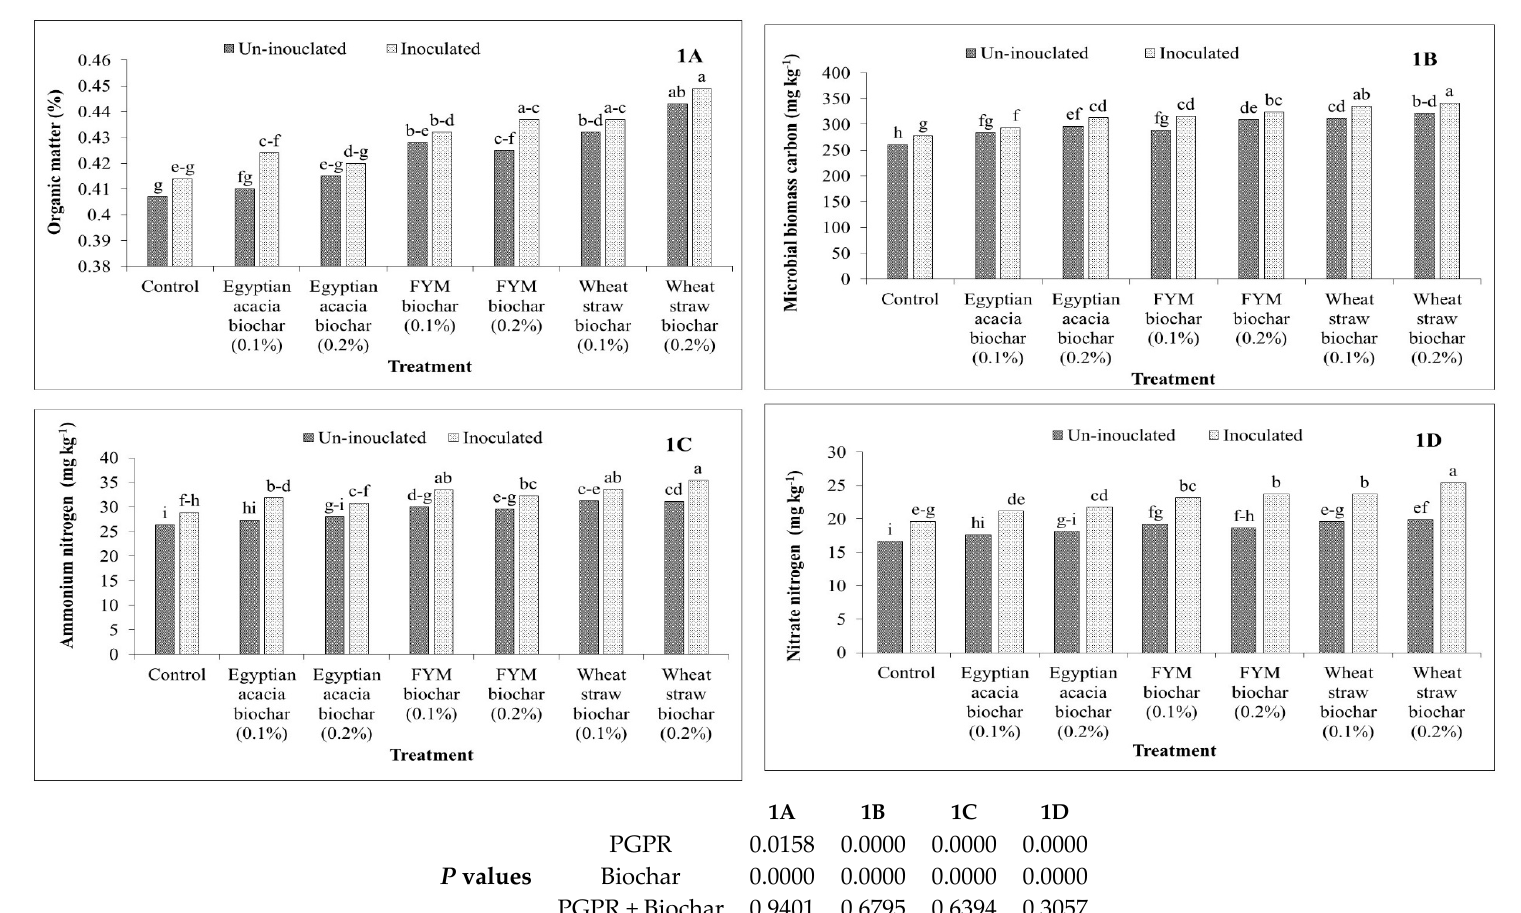
Figure 1. Effects of biochar with and without Bacillus sp. ZM20 on organic matter ( A ): Least significant difference (LSD) 0.0156, microbial biomass carbon ( B ): LSD 14.290, ammonium N ( C ): LSD 2.096, and nitrate N ( D ): LSD 1.6386 under pot trial; (n = 3); bars sharing same letters are statistically not different from each other at p ≤ 0.05.